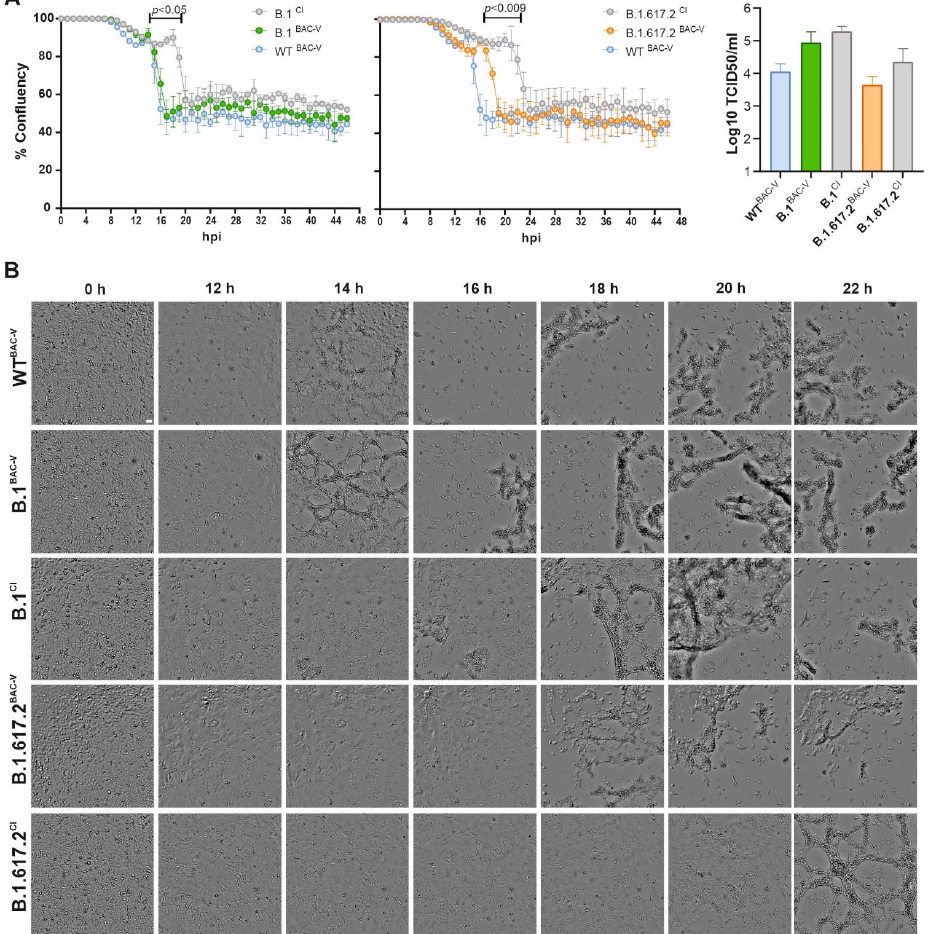
Figure 2. Growth kinetics of clinical and recombinant SARS-CoV-2 variants. ( A ). Graphical presentation of % confluence of infected A549-AT cells (MOI = 1) over time. For normalization, confluence of uninfected control was set to 100%. Measurements were performed every 1 h. Standard deviations derive from three technical replicates and represent two independent biological replicates. Graphs show means ± s.d.; p values were obtained by two-tailed unpaired t -tests (Table S6), time points showing a significant difference between infection with BAC derived virus (BAC-V), and clinical isolates (CI) are indicated. Virus titer in supernatant at 24 hpi are depicted for WT BAC-V (blue), B.1 BAC-V (green), B.1 CI (grey) B.1.617.2 BAC-V (orange), and B.1.617.2 CI (grey). Data are represented as mean with SD of three and four biological replicates. Conditions were compared using One-Way ANOVA revealing no significant differences. The experiment was performed twice yielding similar results. Hours post infection (hpi). ( B ). Bright-field microscopic images at 4 × magnification represent the cytopathic changes observed during the course of infection at indicated time points. Scale bar: 100 µ m. See also Videos